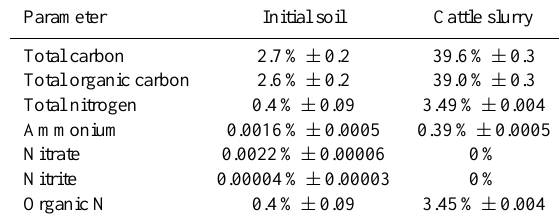
Table 1. Chemical characteristics of control soil and cattle slurry (dry weight basis) used in all of the